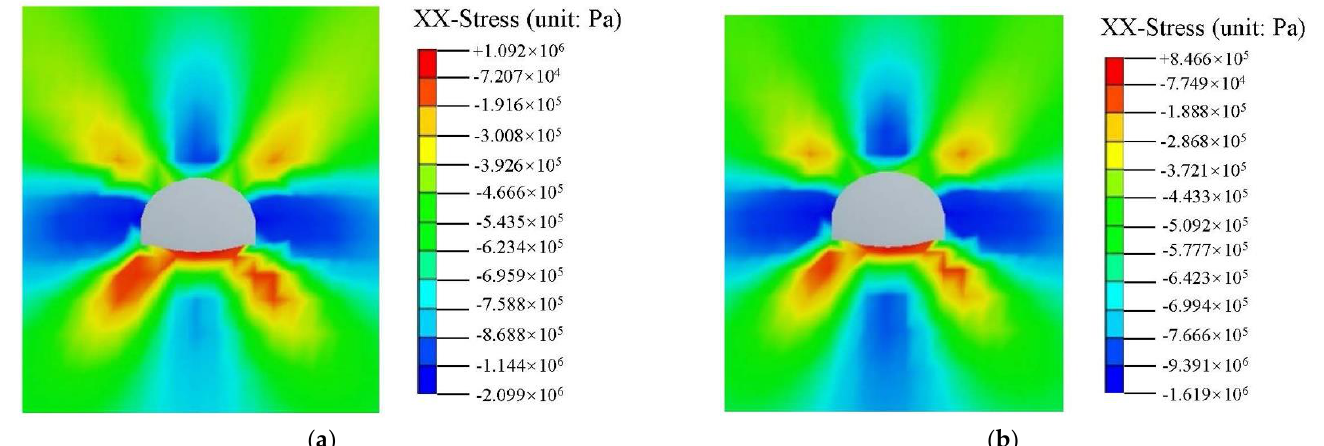
Figure 18. Maps of horizontal stress of surrounding rock: ( a ) original design scheme; ( b ) scheme after collapse treatment.